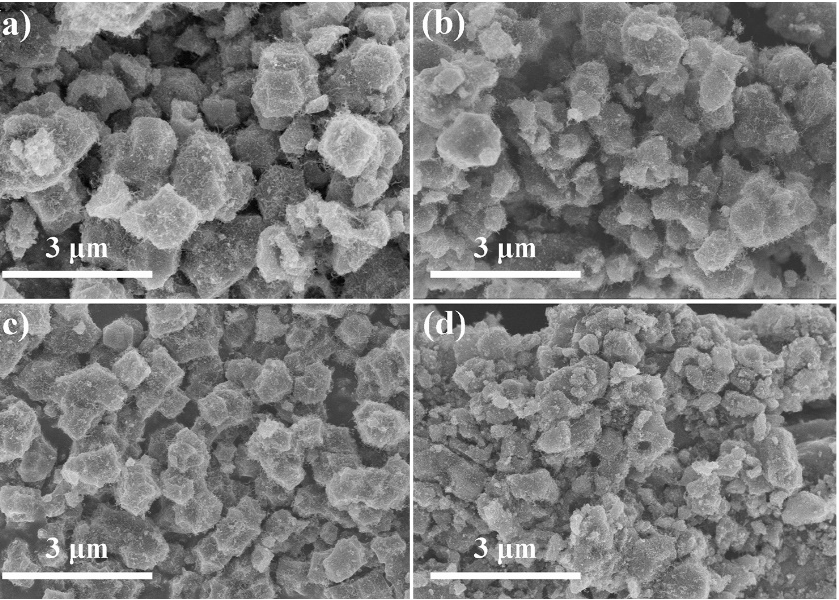
Figure 1. SEM images of ( a ) Co-NCNT-HPC600; ( b ) Co-NCNT-HPC700; ( c ) Co-NCNT-HPC800; ( d ) Co-NCNT-HPC900 at low magnification.